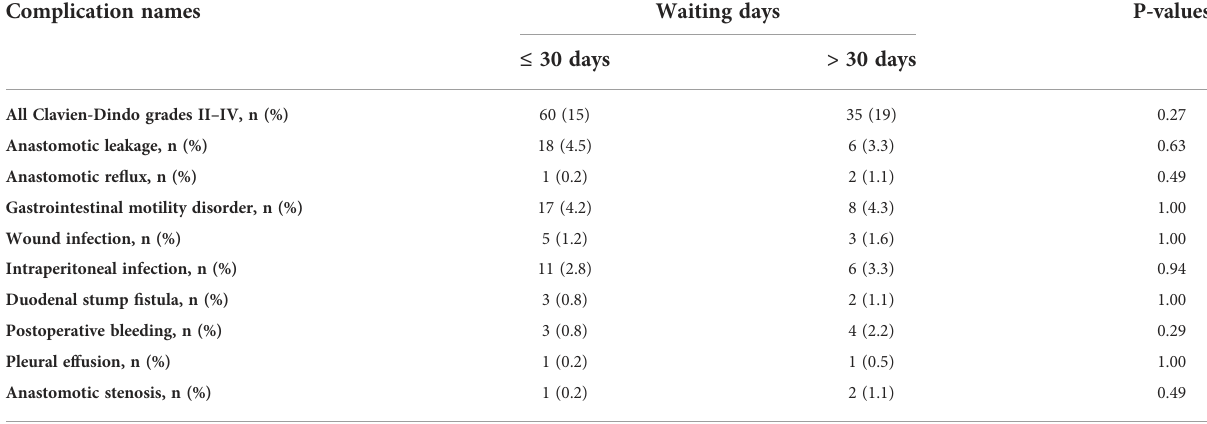
TABLE 4 A comparison of the complications of cases with grades II – IV between the delayed and the short waiting groups.